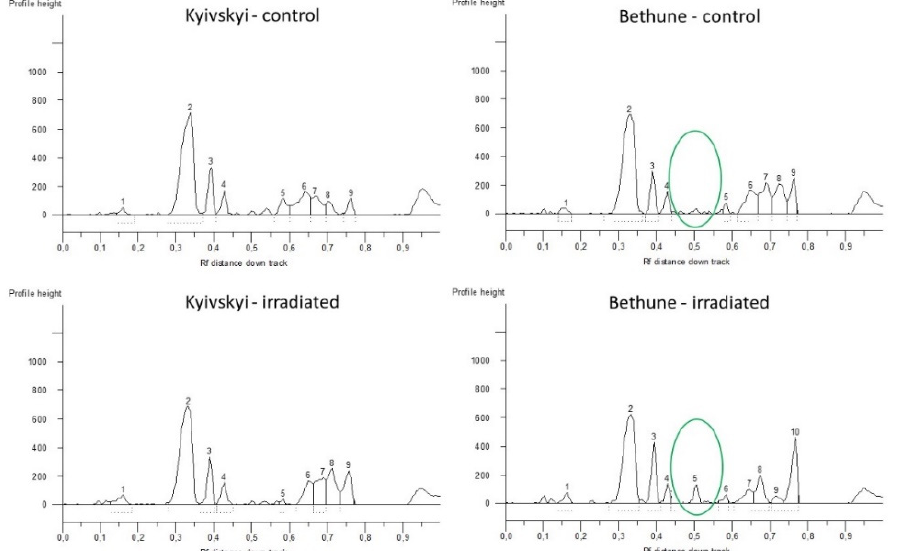
Figure 5. Comparison of obtained dLUTE profiles of common flax varieties Kyivskyi and Bethune grown in the remediated and radio-contaminated field conditions of Chernobyl. x axis—Rf distance down track; y axis—profile height. 1–10—numbering of the generated loci.